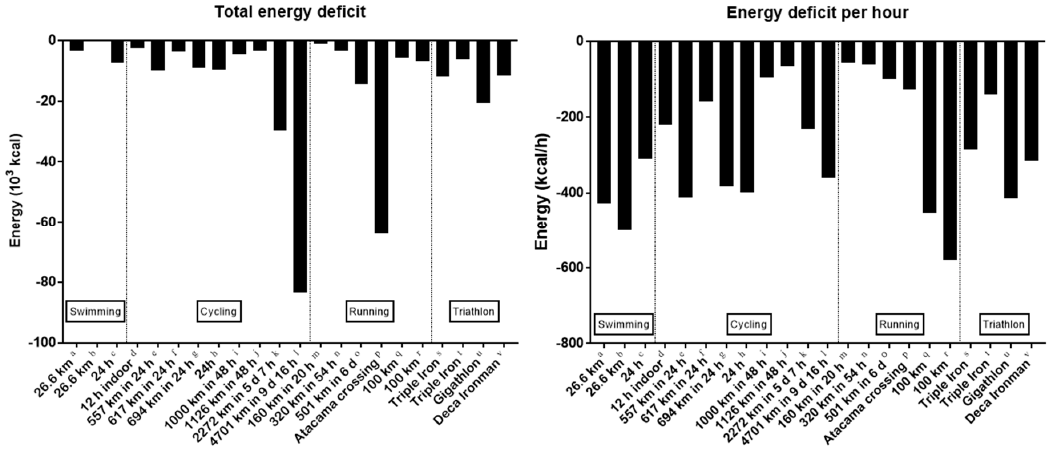
Figure 2. Energy balance in ultra-endurance athletes in swimming, cycling, running, and triathlon.